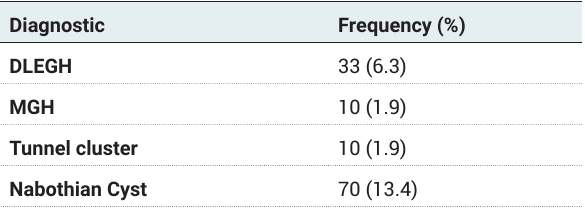
Table 5: Prevalence of various disease conditions in glandular Hyperplasia category